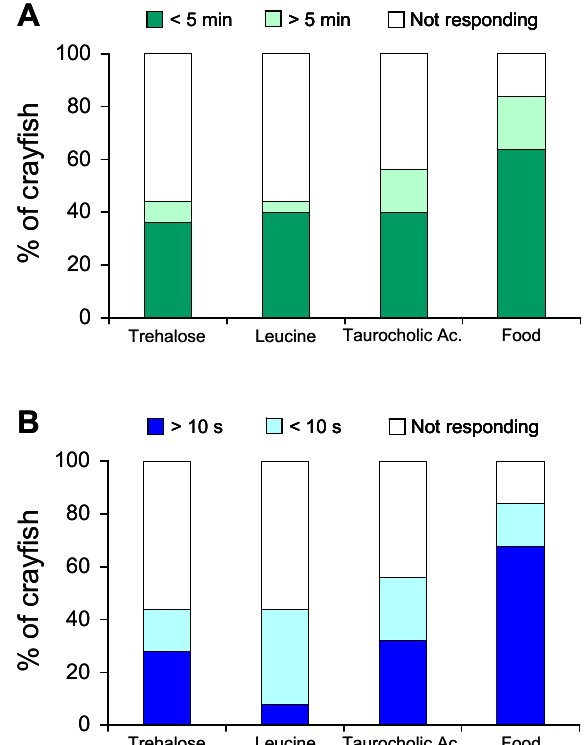
Figure 5. Attractiveness index of trehalose, leucine and taurocholic acid in PVC, expressed as ( A ) the time it took the crayfish to find the dispensers (less or more than 5 min) and ( B ) the time the crayfish spent on the dispensers (less or more than 10 s), as compared to food. Data were obtained from 25 (14 females and 11 males) crayfish.